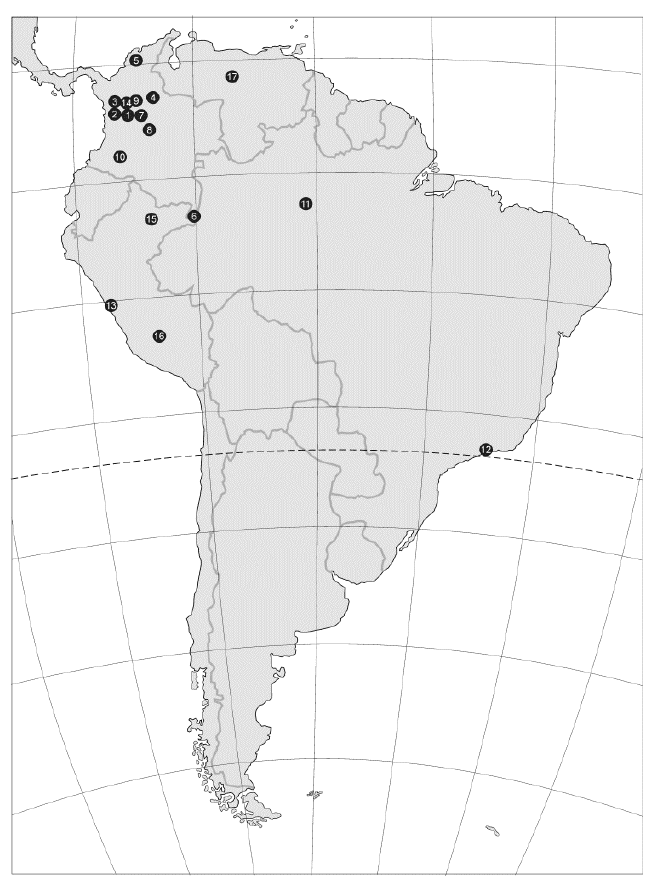
Figure 9. Locations of the species from the genus Rotundabaloghia described by Hirschmann in 1992 [25] from the area of South America.